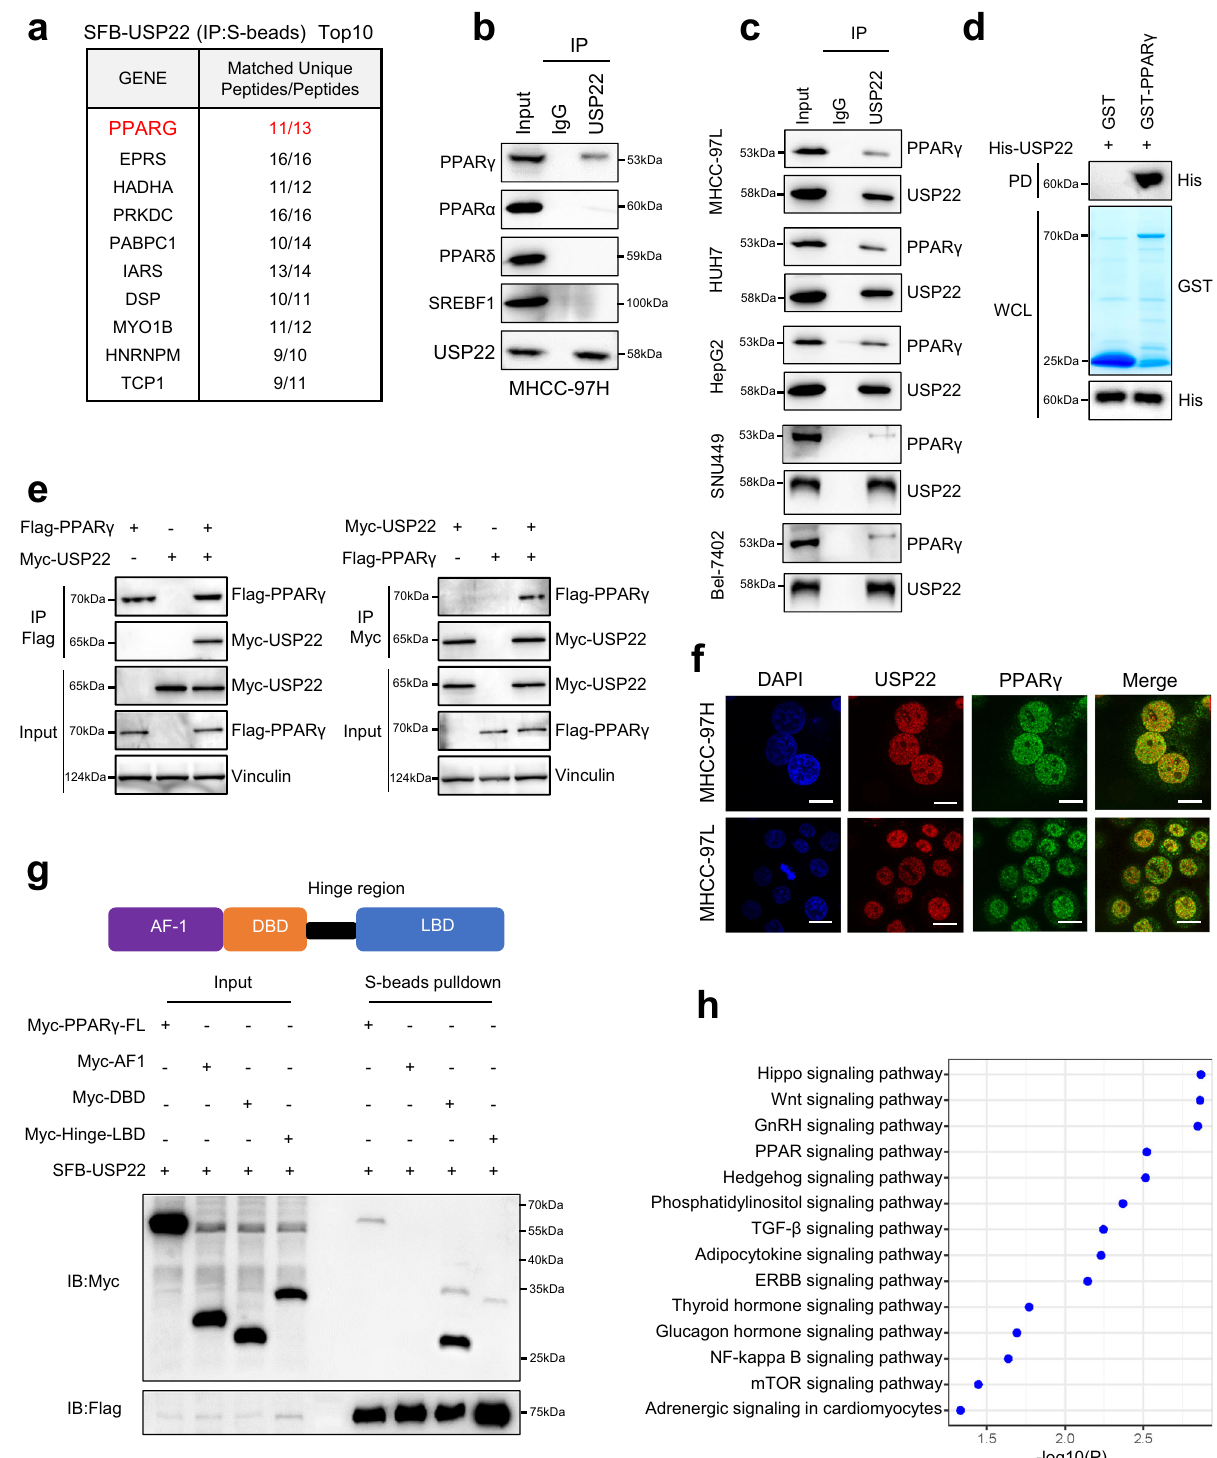
MHCC-97H cells but not in the Flag-PPAR γ -5KR overexpression cells (Supplementary Fig. 7e). Same line with this, knockdown of USP22 in Flag-PPAR γ overexpressing cells had a more signi fi cant inhibitory ability on cell proliferation compared to Flag-PPAR γ - 5KR transduced cells (Supplementary Fig. 7f). In agreement with these fi ndings, reconstitution of PPAR γ in USP22-engineered